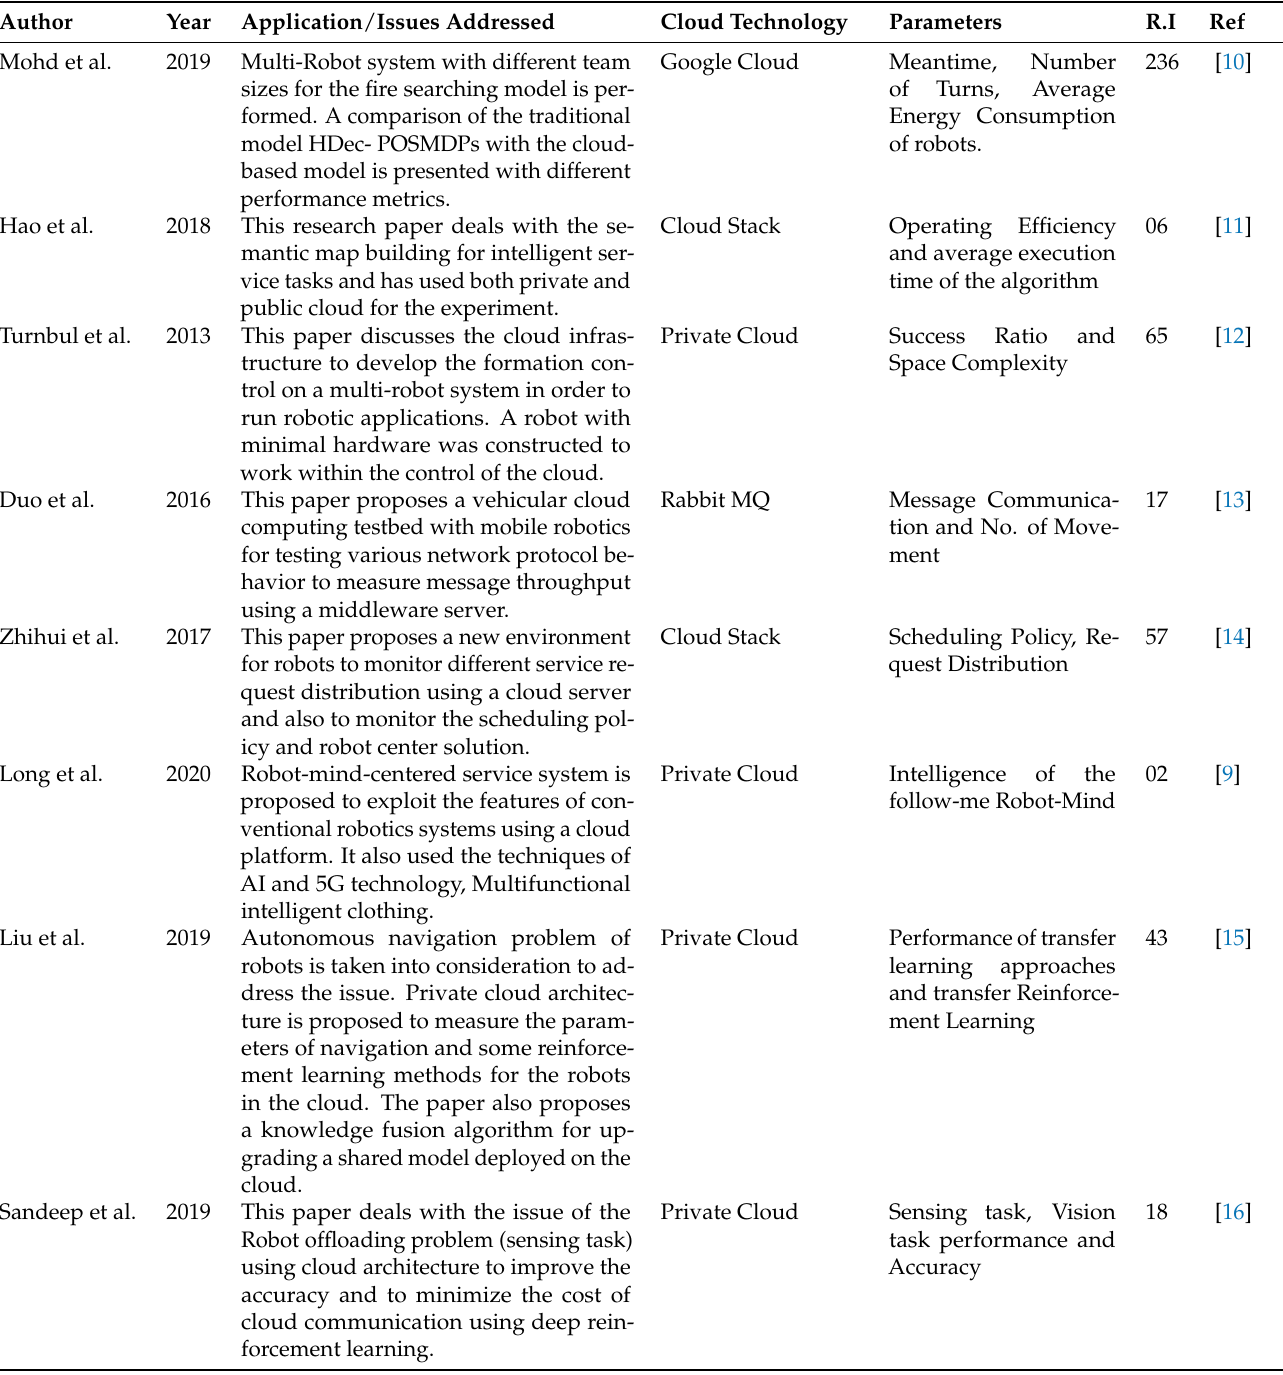
Table 1. Different cloud computing platforms used for robot-based applications in recent